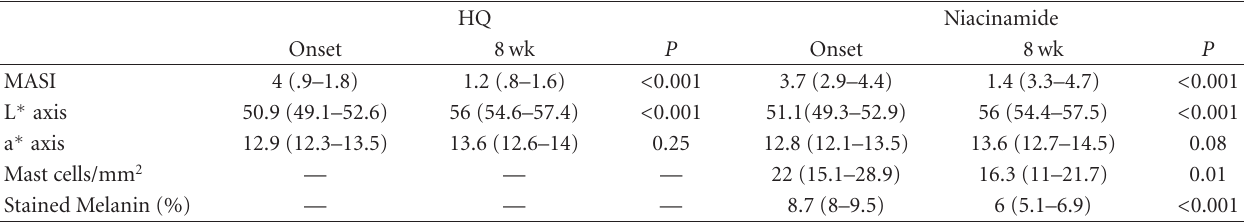
Table 1: Changes in MASI scores and colorimetric values for 4% HQ and 4% niacinamide-treated sides in 27 patients with melasma. Mast cell counts and melanin expression initially and after treatment with niacinamide in 11